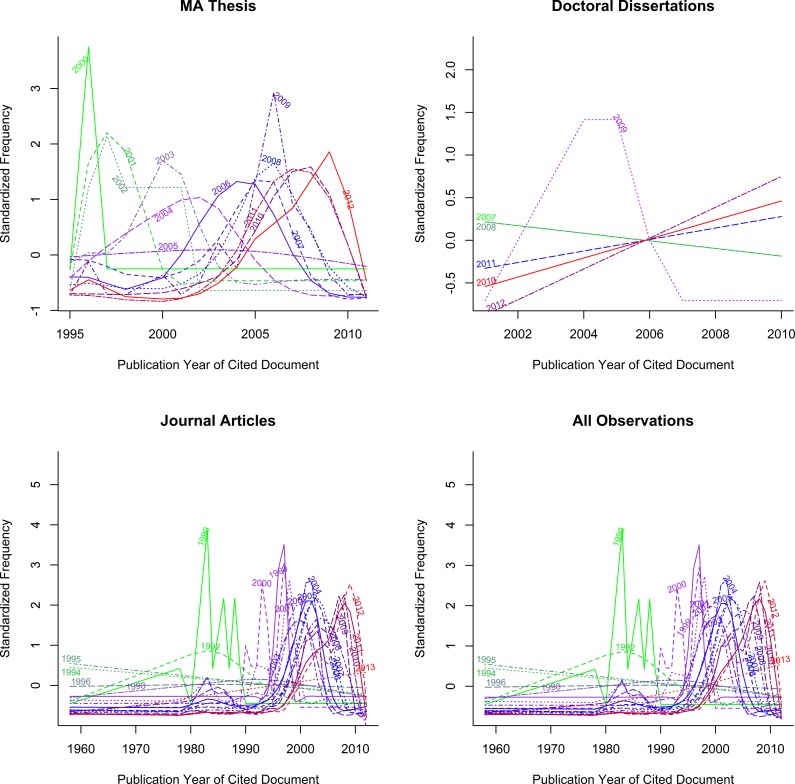
Normalized incoming citations for three strands of CIS research.